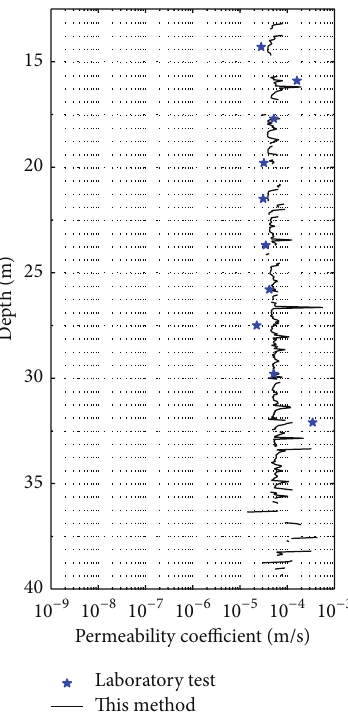
Figure 7: Curve of permeability coefficient changing with depth.